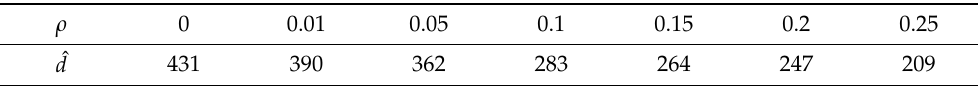
( b ) Figure 4 . ( a ). The trajectories under different packet loss rate 𝜌 , ( b ). The trajectories under different time delay with 𝜌 = 0.1 . It can be seen from Figure 4a that the system equipped with our proposed control- ler has adequate damping to suppress inter-area low-frequency oscillations. Even if the packet loss rate reaches 0.9, the low-frequency oscillation can be still suppressed. More- over, there are only slow changes in the amplitude and the regulating time of the system response as the packet loss rate increases. From Figure 4b, we can know that the effect of damping the low-frequency oscilla- tion will become worse as the delay increases, which also shows the importance of con- sidering delay during the design of controller. In addition, when the delay time increas- es to a certain value, the system will become instable.